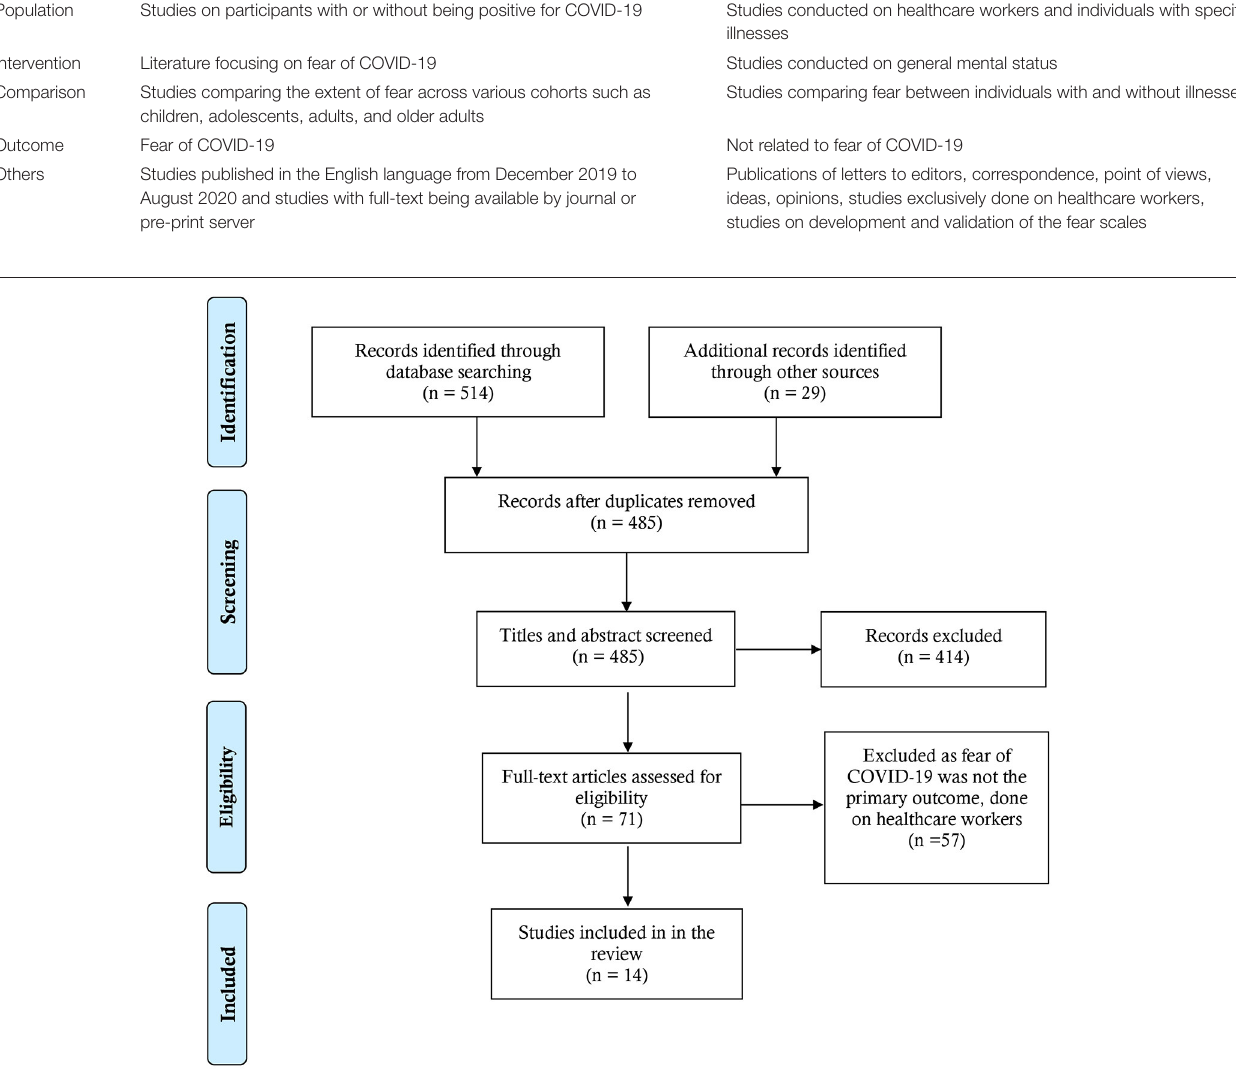
FIGURE 1 | PRISMA flow-chart of this scoping review